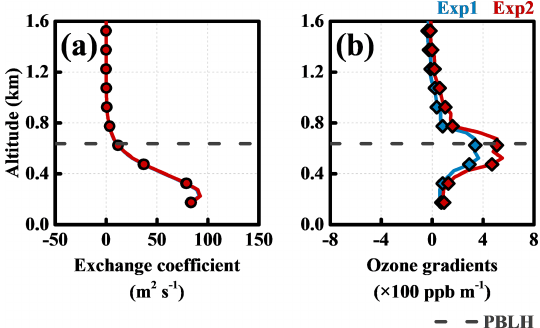
Figure 7. Averaged vertical profiles of turbulence exchange coef- ficients (a) and vertical gradients of ozone (b) of the four cities at 12:00LT. Dashed dark gray line denotes PBLH at this